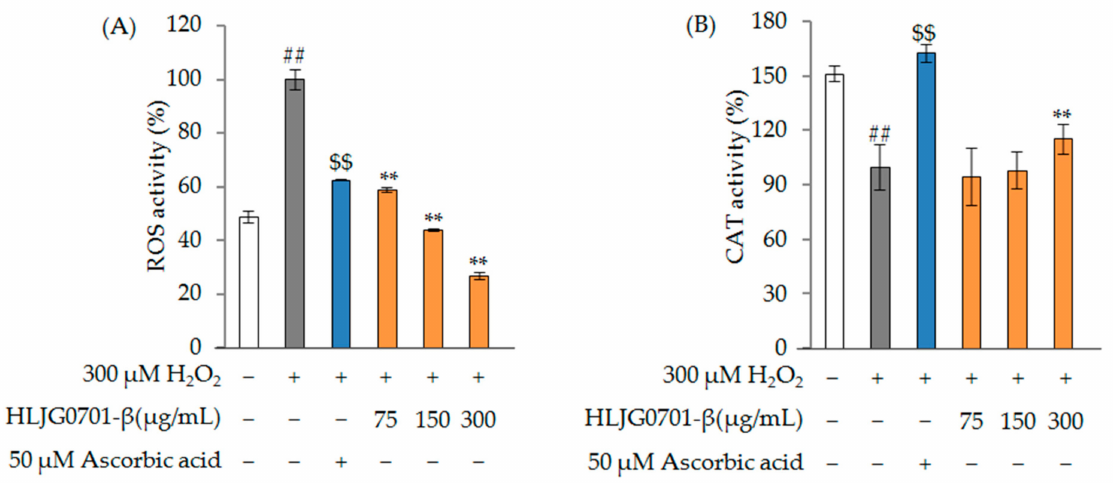
Figure 4. Effect of HLJG0701- β on antioxidant ( A ) ROS ( B ) CAT activity. Data are presented as mean ± standard deviation. Error bar: standard deviation; ##, significant difference compared with control by Student’s t -test, p < 0.01; $$, significant difference compared with negative control by Student’s t -test, p < 0.01; **, significant difference compared with negative control by one-way ANOVA, p <